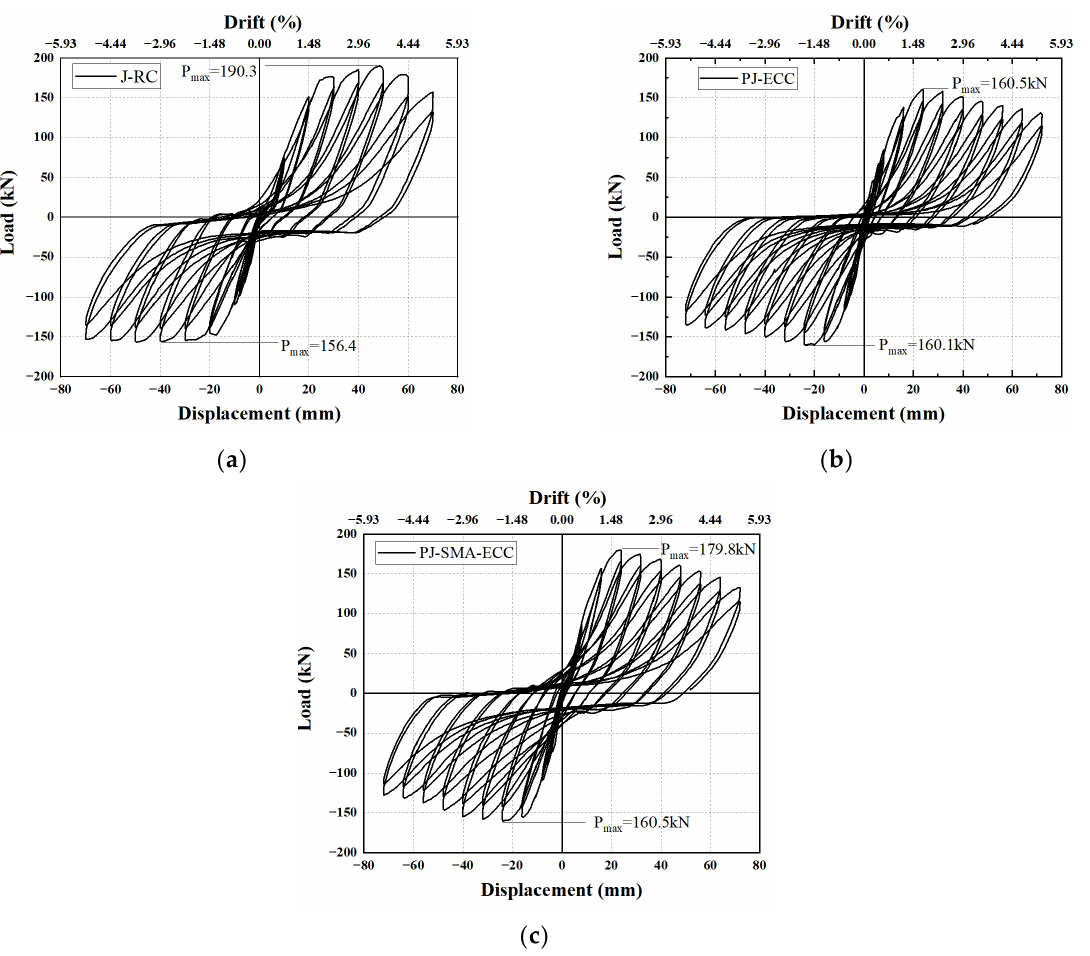
Figure 9. Hysteresis curves of specimens for ( a ) J-RC, ( b ) PJ-ECC, and ( c ) PJ-SMA-ECC.